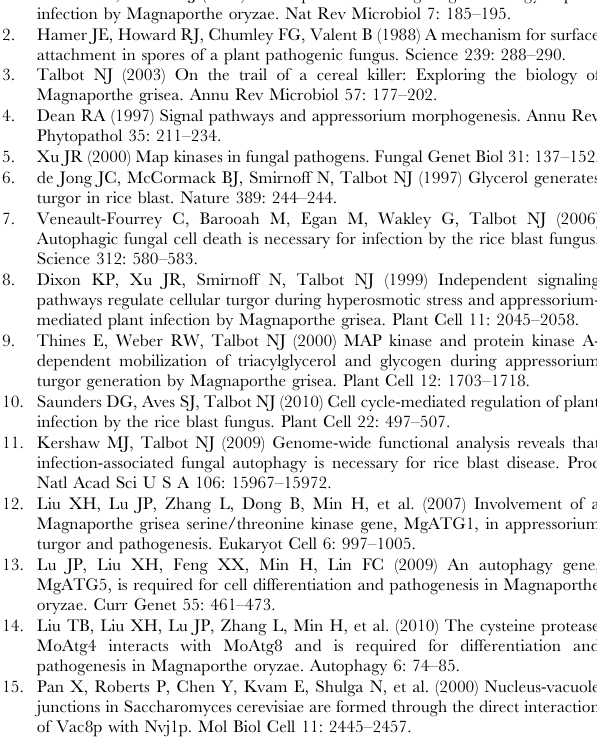
Figure S8 MoTSC13 is involved in maintaining cell wall integrity and hyper osmotic stress adaptation, but not appressorium development or turgor generation. ( A ) Disruption of MoTSC13 reduced hyphal growth of M. oryzae on CM, and made M. oryzae sensitive to hyper osmotic stress and cell wall stress. ( B ) Vegetative growth was impaired by deletion of MoTSC13 . The diameter of colonies of both Guy11 and D Motsc13 mutants grown on CM plates was recorded at indicated times in the line graph presented. ( C ) Conidiation was reduced by deletion of MoTSC13 . A 3 mm mycelium plug was inoculated in triplicate and incubated at 24 u C for 12 days. Conidia generated were collected in 3 ml of distilled water, and 20 m l of conidial suspension used for counting on a hemacytometer. Bar chart shows conidia per cm2 of plate cultures. ( D ) MoTSC13 is dispensable for appressorium development. Bar charts showing the percentage of conidia formaing an appressorium after 6 h or 24 h ( E ) MoTSC13 is dispensable for turgor generation in the appressorium. Bar charts showing the percentage of cell collapse upon incubation in increasing concentrations of glycerol [6]. Table S1 Detailed information of oligonucleotide primers used in this